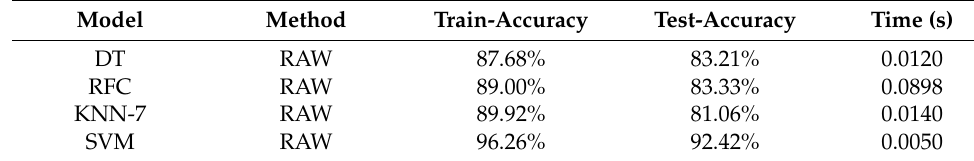
Table 3. Accuracy and the time of original band classification model.